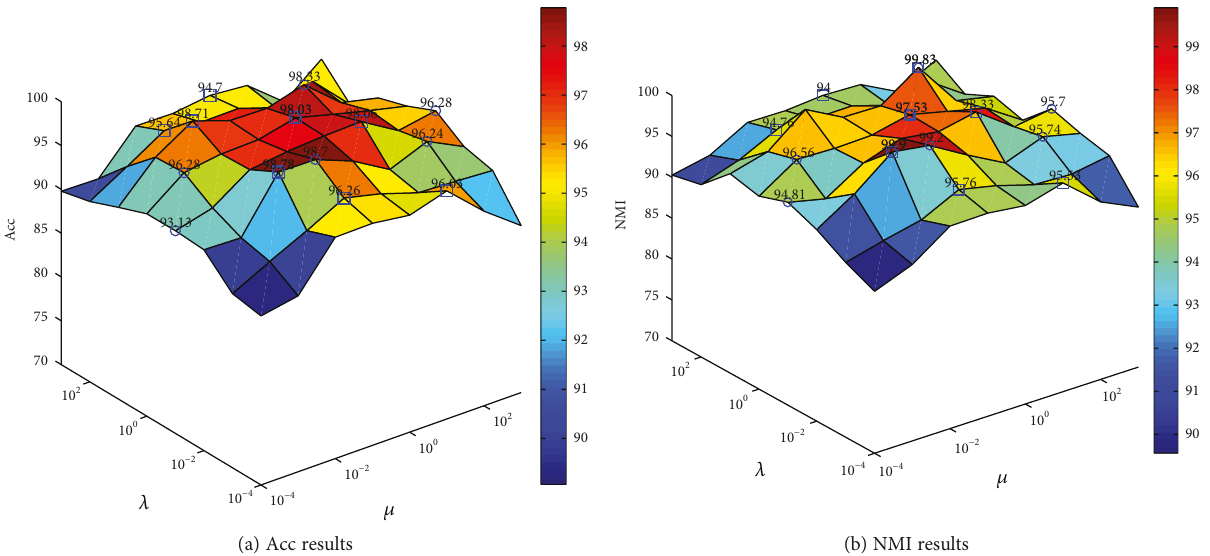
Figure 8: Clustering accuracy of the proposed method with respect to the parameters μ and λ on the leukemia